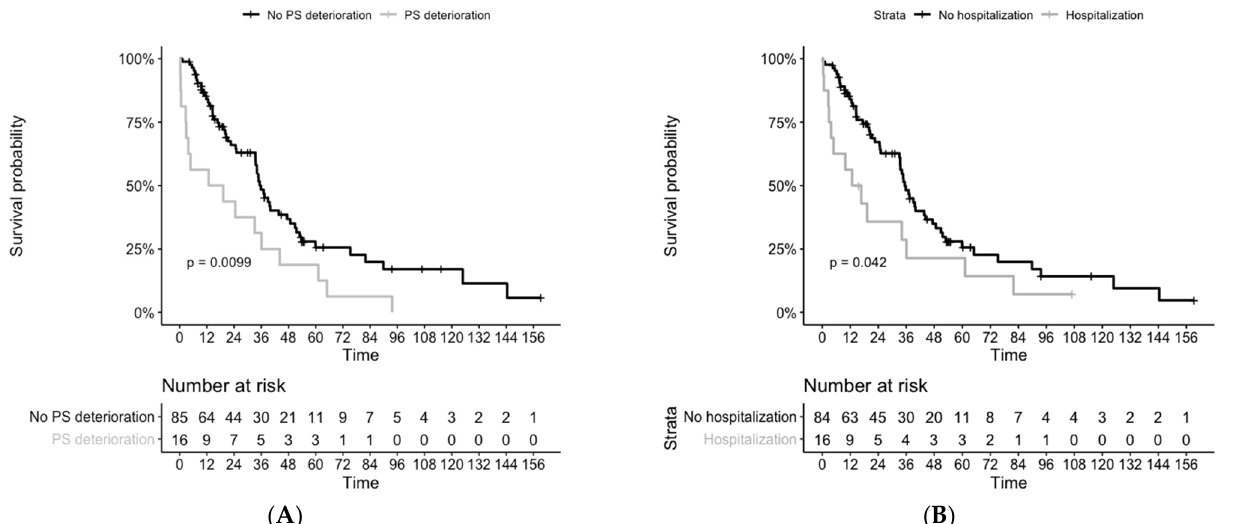
Figure 2. Overall survival from histological diagnosis, depending on pre-TKI period complications: ( A ) with or without performance status deterioration, 1 patient with missing survival data ( B ) with or without any hospitalization. PS = performance status.